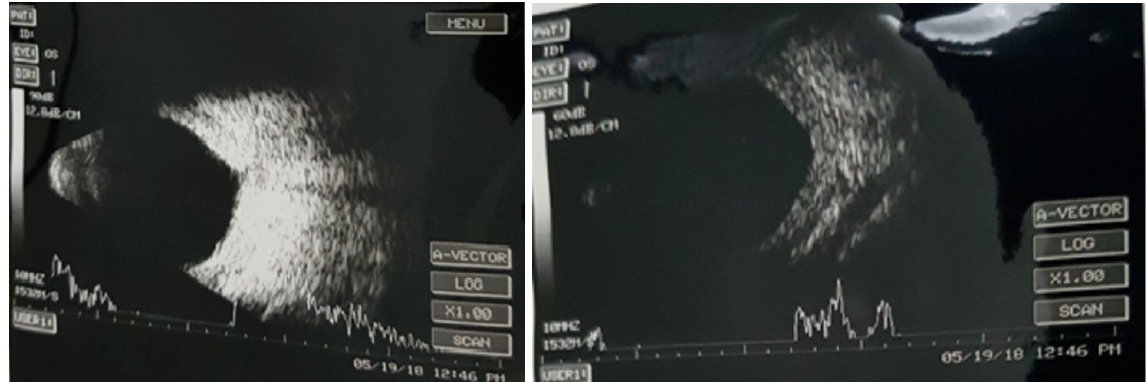
Figure 3: B-scan ultrasonography after 2 weeks in postoperative period showing resolution of choroidal and retinal